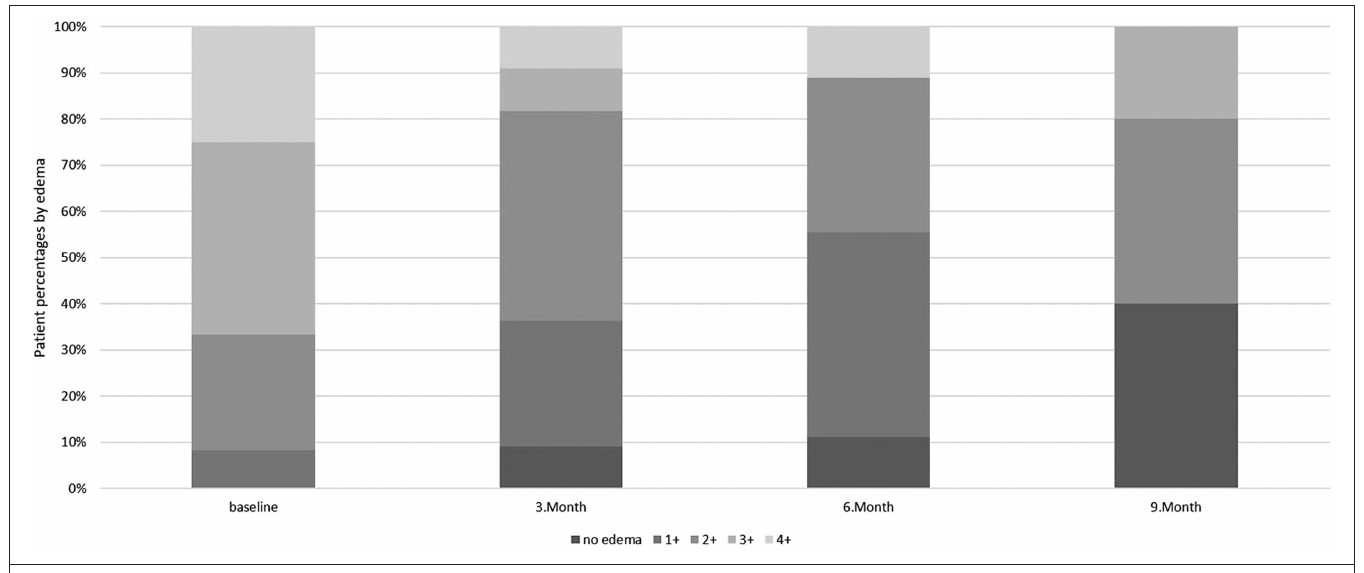
Figure 3. Temporal change of pretibial edema ( P = .005).